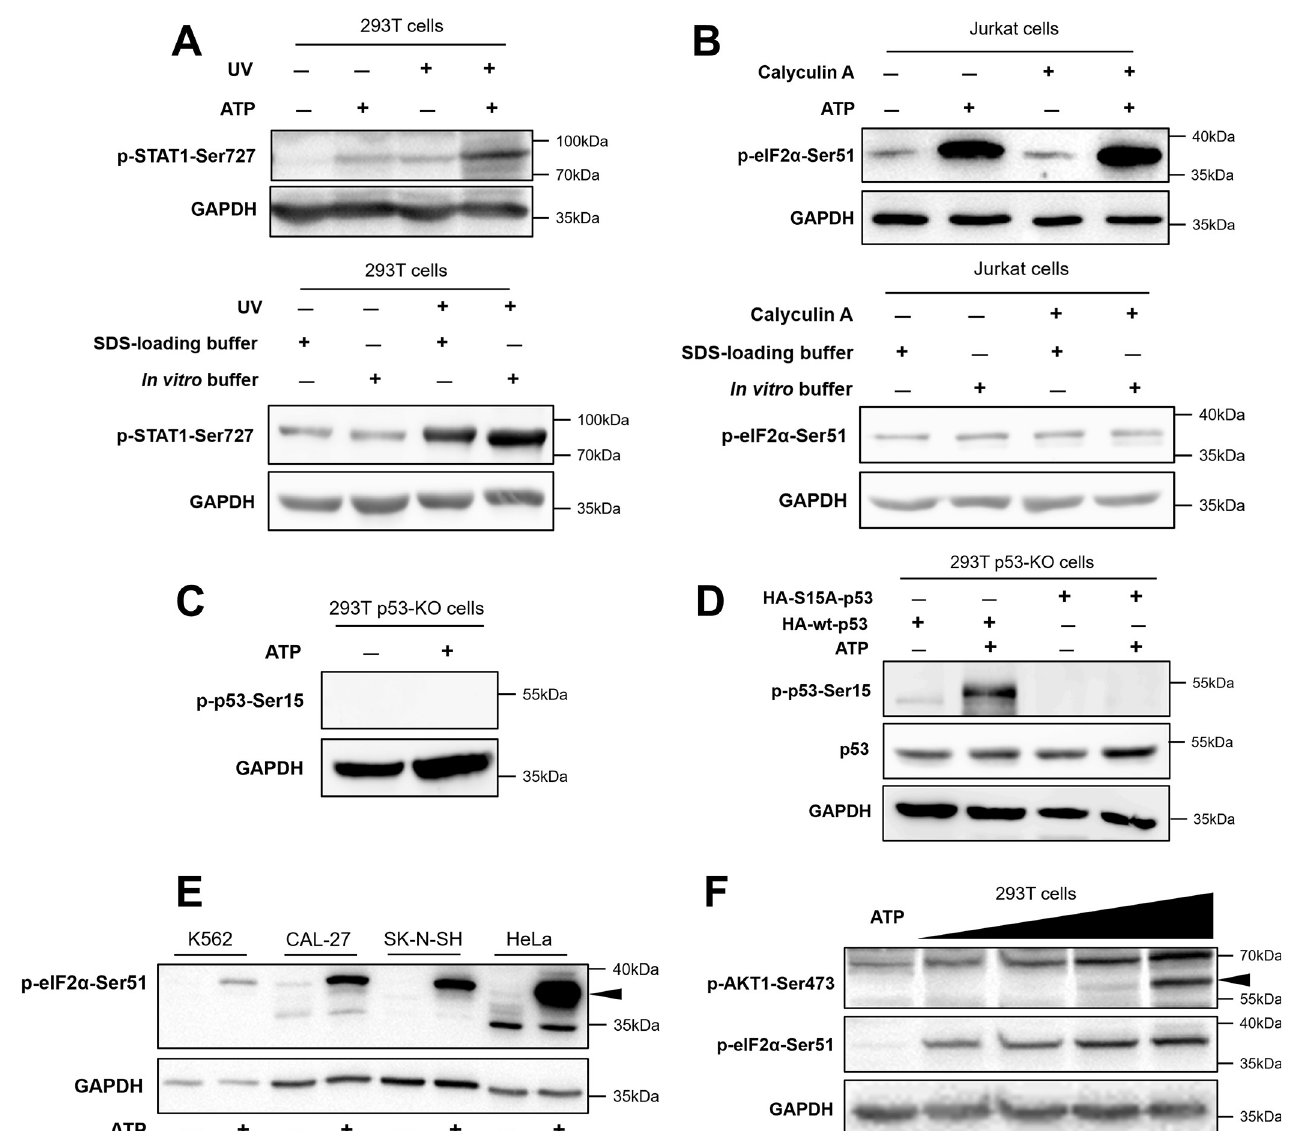
Fig 1. Development of a feasible, ATP-dependent in vitro phosphorylation system. (A) Upper panel: 293T cells were first treated with or without UV-A irradiation for 30 min, and cells were then harvested and lysed in in vitro buffer. Lysates were incubated with or without 5 mM ATP for 30 min. Phospho- STAT1 (Ser727) was detected by western blotting. Lower panel: 293T cells with or without UV-A treatment were lysed by in vitro buffer or SDS-loading buffer, then Phospho-STAT1 (Ser727) was detected by western blotting. (B) Upper panel: Jurkat cells were first treated with or without calyculin A (100 nM) for 30 min, and cells were then harvested and lysed in in vitro buffer. Next, lysates were incubated with or without 5 mM ATP for 30 min. Phospho-eIF2 α (Ser51) was detected by western blotting. Lower panel: Jurkat cells with or without calyculin A treatment were lysed by in vitro buffer or SDS-loading buffer, then phospho- eIF2 α (Ser51) was detected by western blotting. (C) The p53-KO 293T cells were harvested and lysed in in vitro buffer. Then lysates were incubated with or without 5 mM ATP for 30 min. (D) The p53-KO 293T cells were transfected with wt-p53 or S15A-p53 for 24h, after that cells were lysed in in vitro buffer and then incubated with or without 5 mM ATP for 30 min. (E) K562, CAL-27, SK-N-SH, and HeLa cells were harvested, lysed in in vitro buffer, and then incubated with or without 5 mM ATP for 30 min. Phospho-eIF2 α (Ser51) was detected by western blotting. (F) 293T cells were harvested, lysed in in vitro buffer, and incubated with 0, 0.5, 1, 2, or 5 mM ATP for 30 min. Phospho-eIF2 α (Ser51) and phospho-AKT1 (Ser473) were detected by western